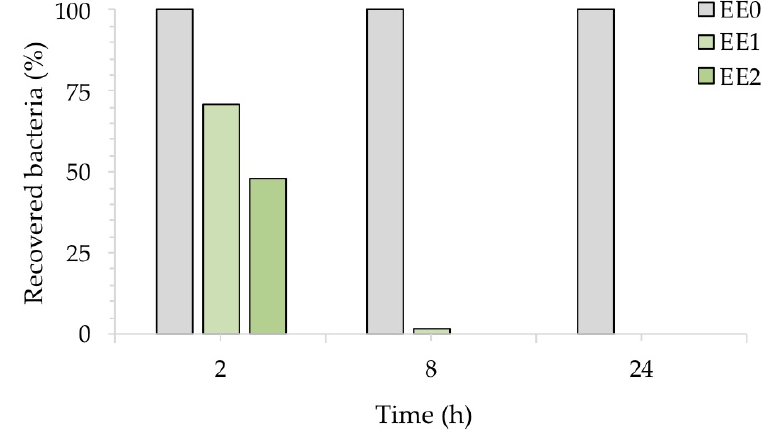
Figure 6. Antibacterial activity of the test surfaces against E. coli after, 2, 8 and 24 h of exposure.